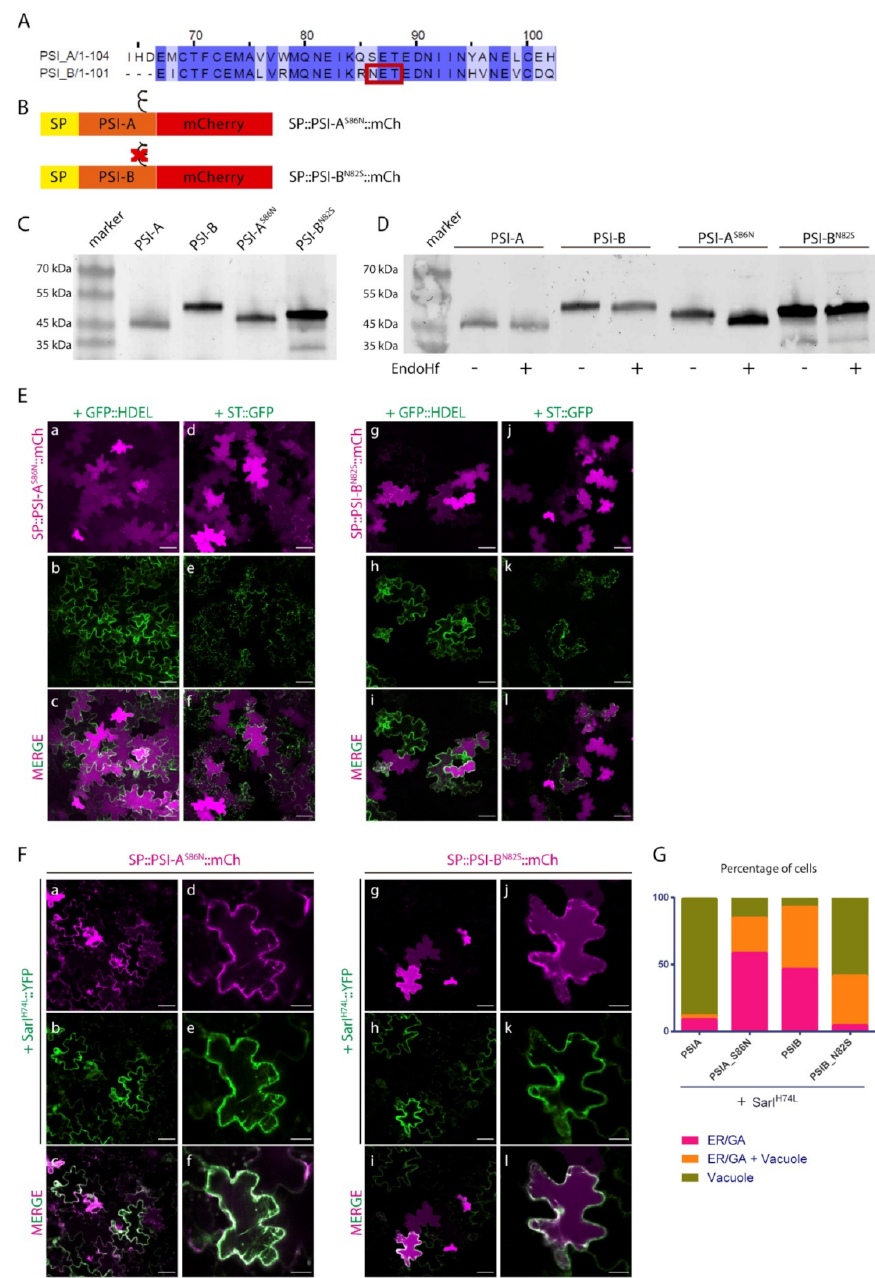
Figure 4. The expression of PSIs’ glycosylation mutants in N. tabacum epidermal cells highlights a putative role for N-glycosylation in tra ffi cking. ( A ) Alignment of cardosins A and B PSIs, showing the glycosylation motif on PSI-B–red box. ( B ) Schematic representation of the mutated versions produced. The symbol ξ represents the glycosylation motif. ( C ) Western blot of the native and mutated versions of the PSIs, evidencing the di ff erences in migration between them. ( D ) Endoglycosidase H assay result of all PSIs. Note the shift in protein migration for PSI-A S86N . ( E ) Co-expression of SP::PSI-A S86N ::mCh with the ER marker GFP::HDEL (a–c) and the Golgi marker ST::GFP (d–f) and SP::PSI-B N82S ::mCh with GFP::HDEL (g–i) and ST::GFP (j–l). Single images for both channels and the composite image are provided. ( F ) Co-expression of SP::PSI-A S86N ::mCh (a–f) and SP::PSI-B N82S ::mCh (g–l) with the dominant negative mutant SarI H74L ::YFP indicate di ff erences in the sensitivity of the mutants to this blockage. ( G ) Bar graph comparing the localization between the mutated and native PSI forms under the e ff ect of SarI H74L ::YFP. For the quantification, we considered that the total number of cells with fluorescent signals defines a 100% value, and among this population, the di ff erent localization patterns were then scored. All observations and images were acquired 3 days post-infiltration. Images were analyzed and processed using ImageJ / Fiji software. Scale bars: ( D )—50 µ m; ( E )—left panels, 50 µ m, and right panels, 20 µ